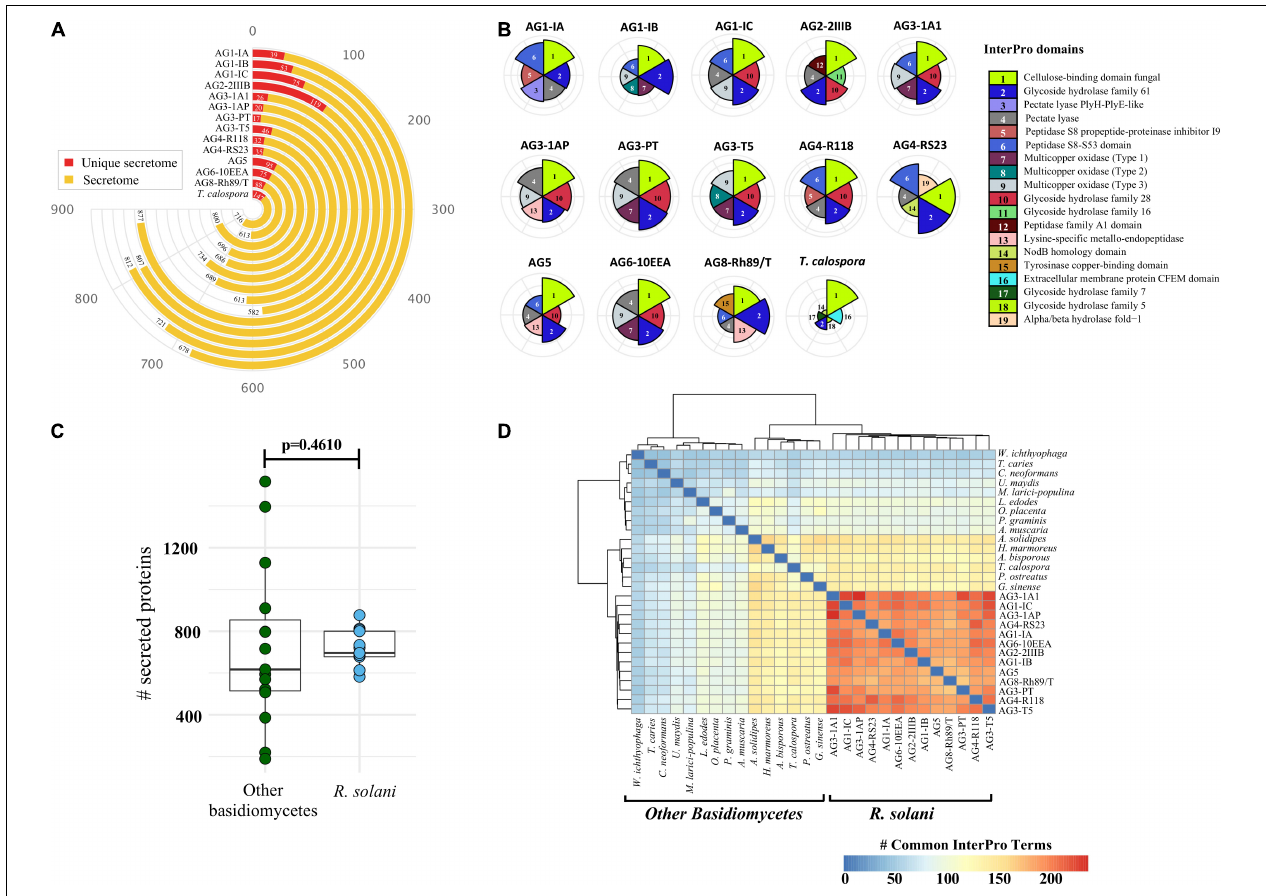
FIGURE 4 | The secreted proteins. (A) Number of predicted proteins in the secretome of each fungal isolate (highlighted in yellow). The secreted proteins predicted in the unique proteome of each isolate is highlighted in red. (B) Comparative analysis of the top six highly enriched InterPro domains in the secretome. (C) Comparative analysis of the total number of secreted proteins predicted in R. solani isolates as compared to other basidiomycetes used in this study. P -value is computed using the unpaired Wilcoxon-rank sum test. (D) Heatmap showing the pairwise comparison of the InterPro terms commonly shared by the secretome of R. solani isolates as well as other basidiomycetes. The strong hierarchical clustering of R. solani isolates highlights their functionally unique and distinct secretome profile as compared to other